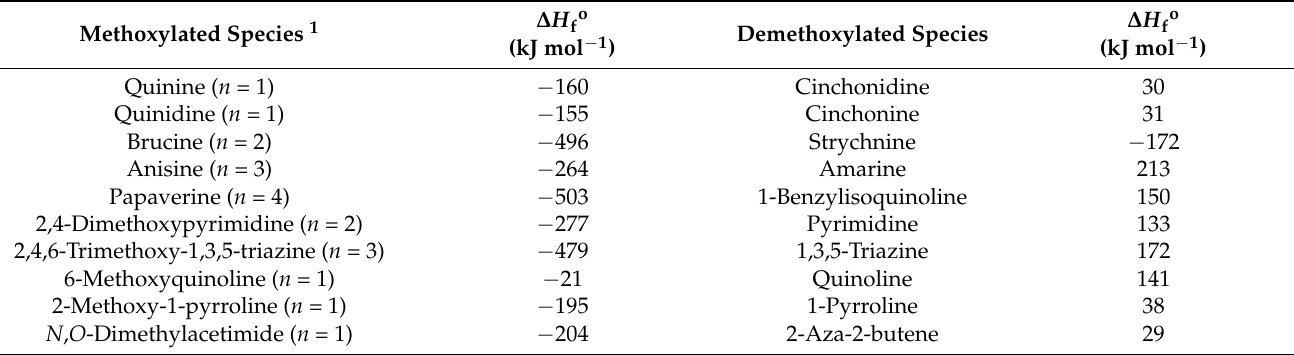
Table 2. Condensed phase enthalpies of formation of methoxylated and demethoxylated species; alkaloids (all necessarily solid) and related